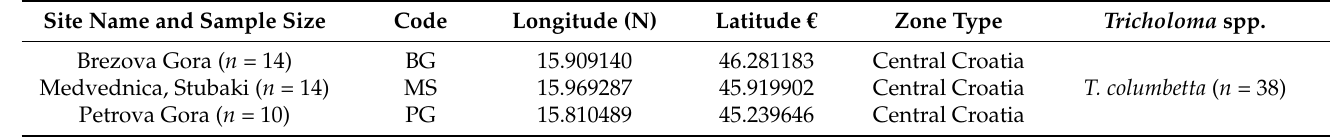
Table 1. Description of study sites of Tricholoma spp. mushroom sample